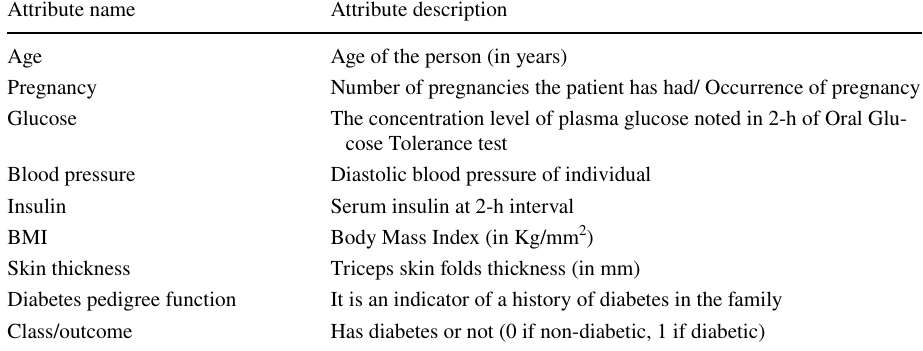
Table 6 Attribute description of the PIMA